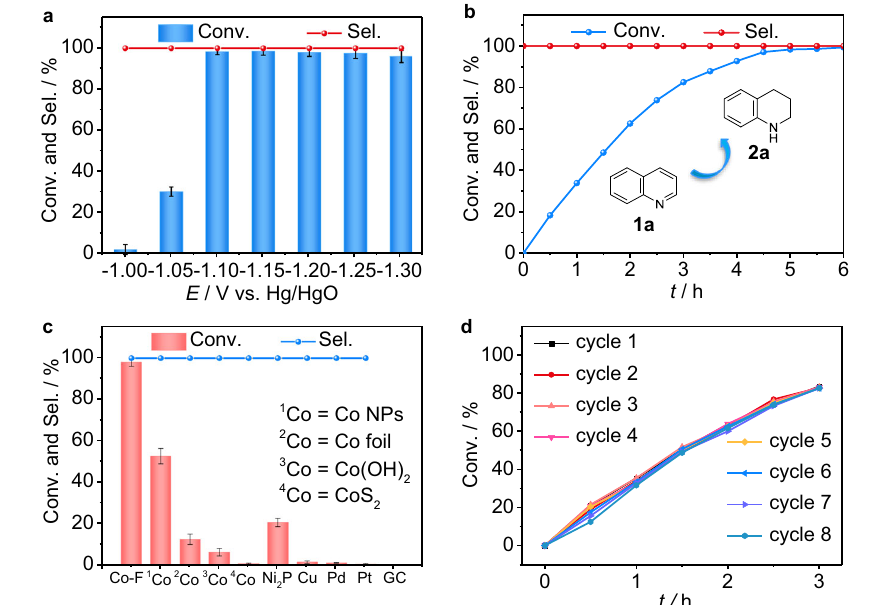
Fig. 2| Performanceoftheelectrocatalytichydrogenationofquinolinesovera Co-Fcathode.a Potential-dependentand b time-dependent 1a conversion(Conv.) and 2a selectivity (Sel.) over the Co-F. c Comparison results of converting 1a to 2a overotherelectrodes. d Cycle-dependent 1a Conv.overtheCo-Fwithin3hplotting